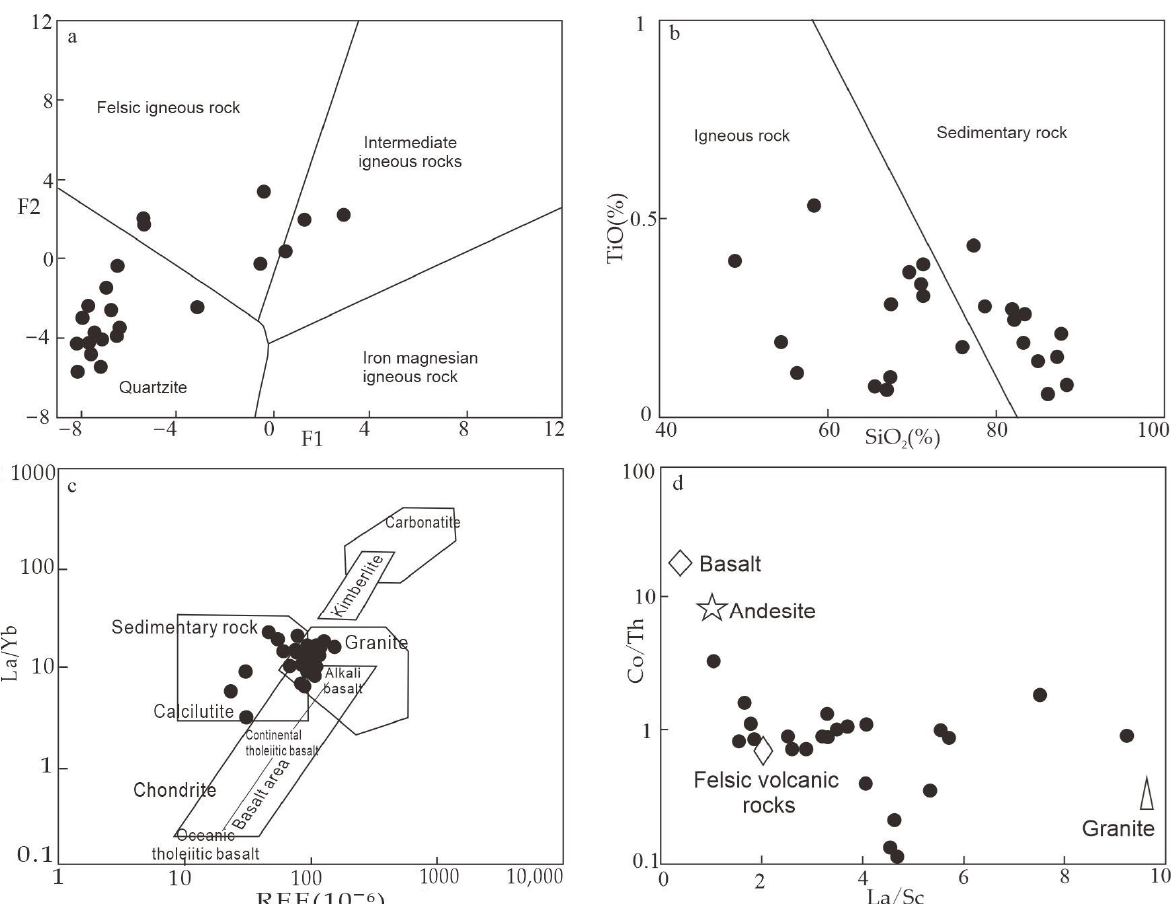
Figure 6. The source rock discrimination diagrams for the Longmaxi Formation black shale in the Yanyuan Basin ( a ); ( b ) base map from [33]; ( c ) base map from [34]; ( d ) base map from [36].